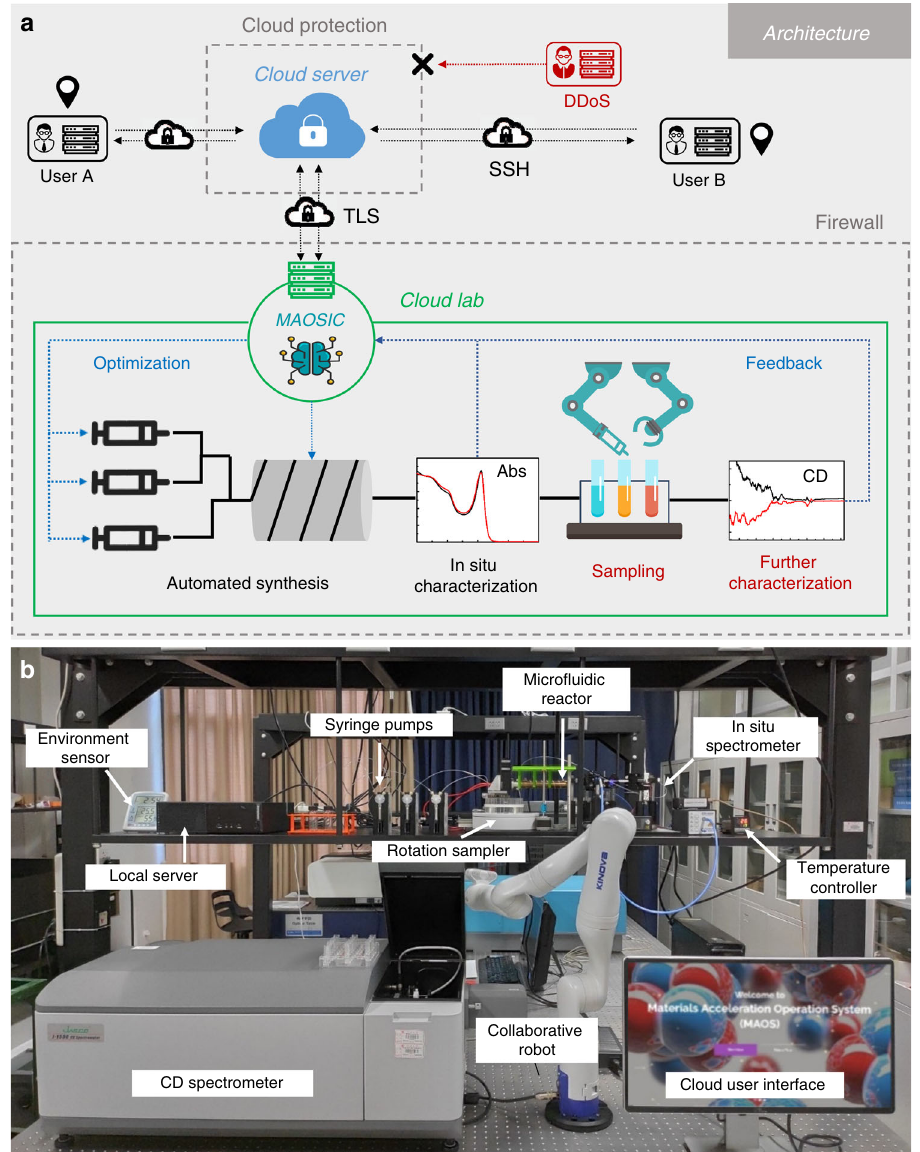
Fig. 1 Work fl ow and photograph of the cloud lab for discovering new optically active IPNCs. a MAOSIC allows remote users to interact with the b integrated equipment in the lab through the cloud server. Encrypted communication and fi rewalls were utilized to maintain data security and transfer stability. Automatic reactions took place in micro fl uidic reactors and under in situ monitoring through the absorption spectrum. Collaborative robots handled the automatic sampling task for CD measurement. All characterization data were sent back to the analysis and optimization module in MAOSIC for autonomous